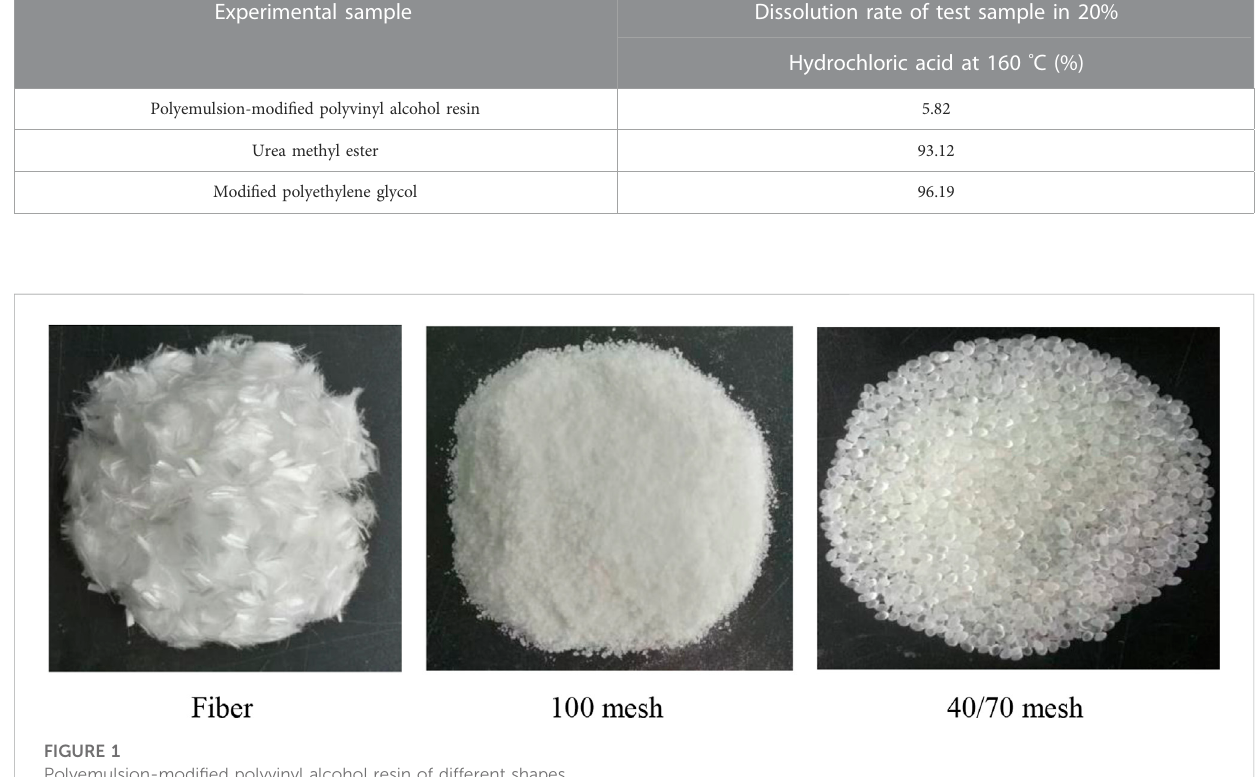
Figure 1. Polyemulsion-modi fi ed polyvinyl alcohol can be processed into fi ber, 100 mesh particles, and 40/70 mesh temporary plugging agent.